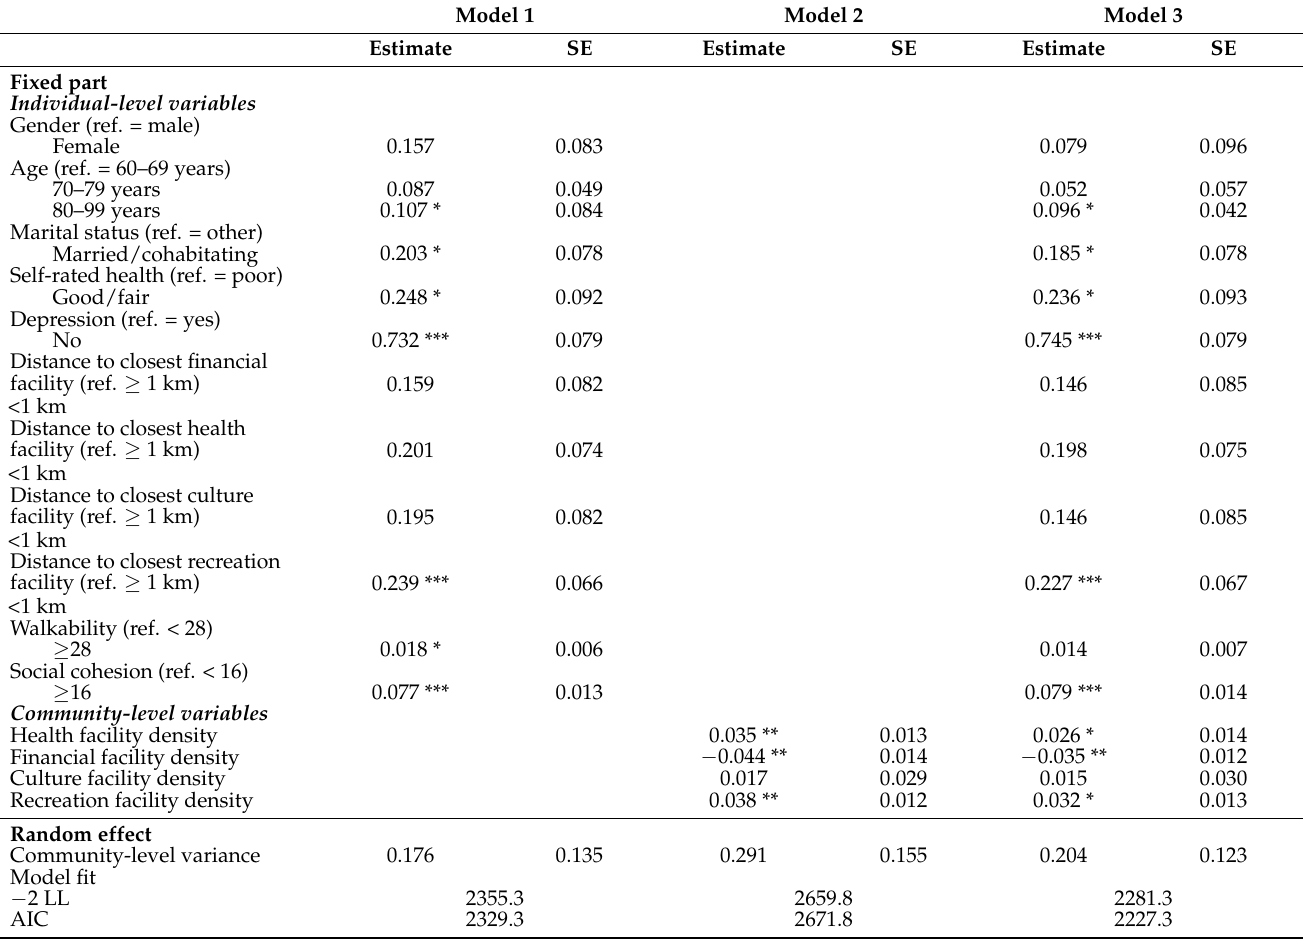
Table 2. Individual and community factors of participants’ subjective